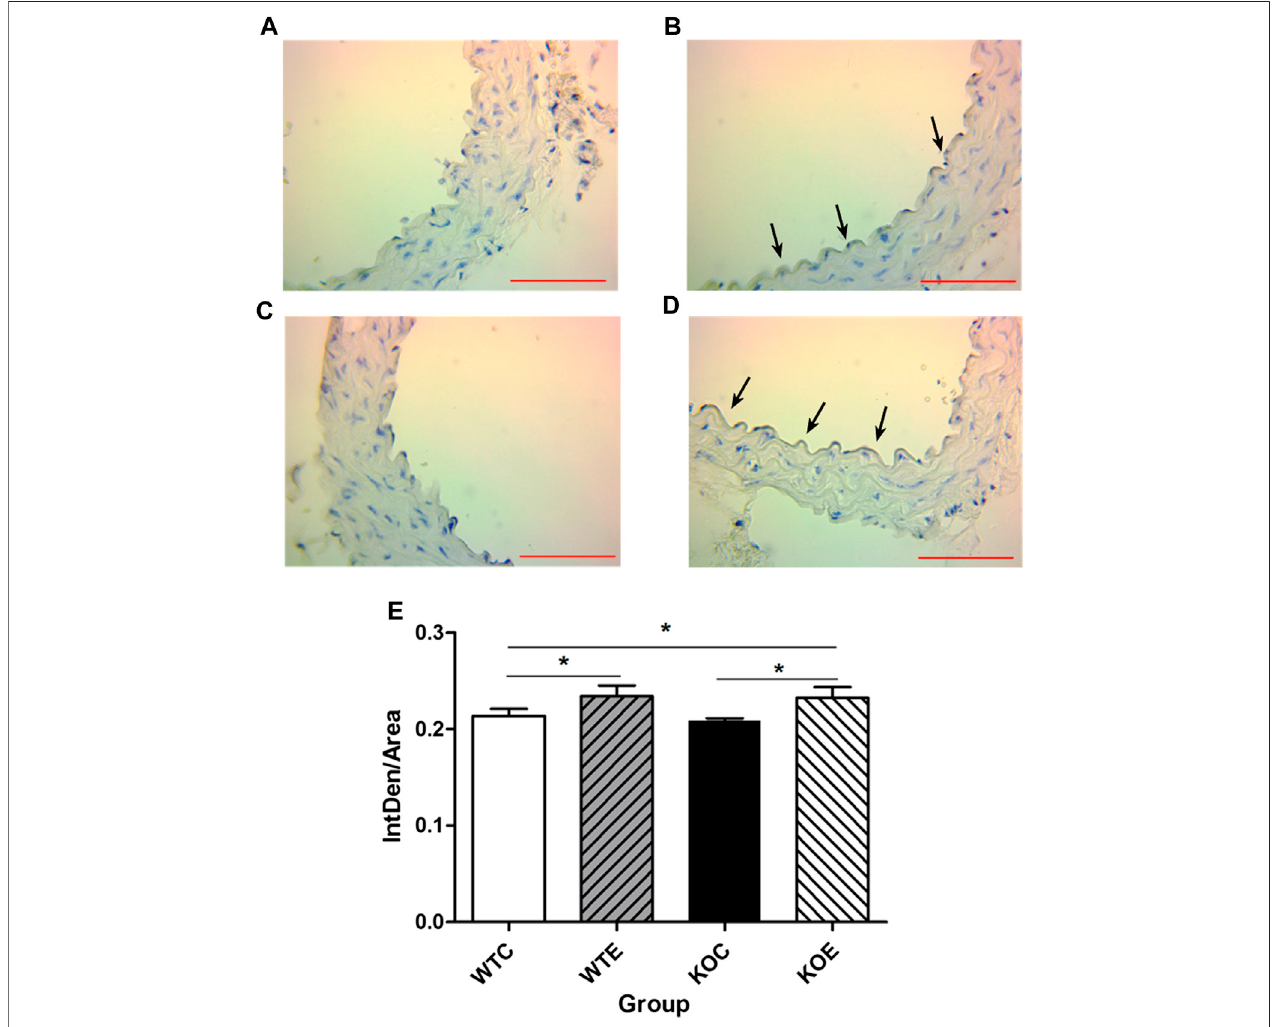
FIGURE 3 | Immunohistochemistry Results of ACE 6 – 8 weeks C57/B6 mice, with or without Nrf2 knockout were exposed to either fi ltered air or air containing particulate matter (PM) for six weeks, and then the vascular tissues were collected, embedded in paraf fi n and subjected to immunohistochemistry for ACE. N (cid:2) 6 per group. WTC was C57 wild-type control group, WTE was C57 wild-type PM exposure group, KOC was Nrf2-/- group control group, and KOE was Nrf2-/- group PM exposuregroup. Scalebars are1,000 μ m and magni fi cation is400 × . *:statistically differentbetweenthe twogroups( p < 0.05) (A) :Immunohistochemistry Results of ACE in WTC group (B) : Immunohistochemistry Results of ACE in WTE group (C) : Immunohistochemistry Results of ACE in KOC group (D) : Immunohistochemistry Results of ACE in KOE group (E) : Quanti fi cation of the ACE